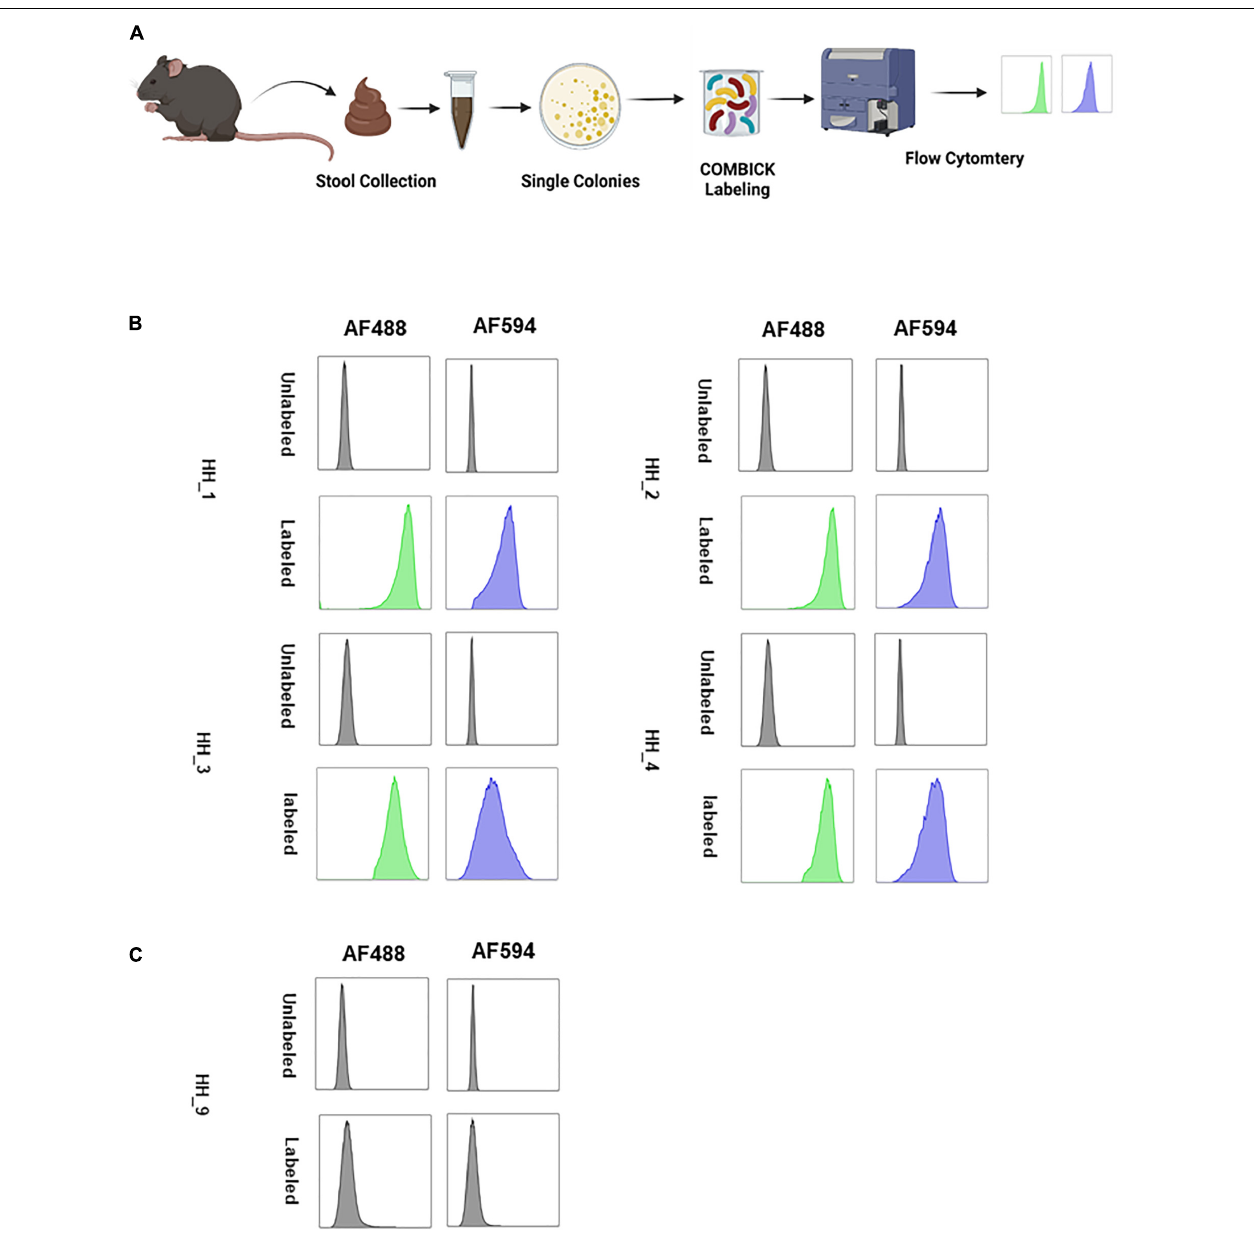
FIGURE 6 | COMBICK enables labeling anaerobic bacteria isolated directly from stool. Labeling live anaerobic bacteria directly isolated from stool. (A) Illustration of the experiment scheme. Single bacteria colonies were isolated from stool, labeled by COMBICK and analyzed by flow cytometry. The bacterial isolates were named HH_#, (# for sequential arbitrary numbers). (B) Flow cytometry histograms of the isolated bacteria labeled by COMBICK. Each column represents a different fluorophore channel. The upper row of each bacteria represents the unlabeled control, and the lower row represents the bacteria labeled with both fluorophores. (C) Flow cytometry histograms of the isolated bacteria that was not successfully labeled by COMBICK. Each column represents a different fluorophore channel. The upper row represents the unlabeled control, and the lower row the bacteria after applying COMBICK labeling.